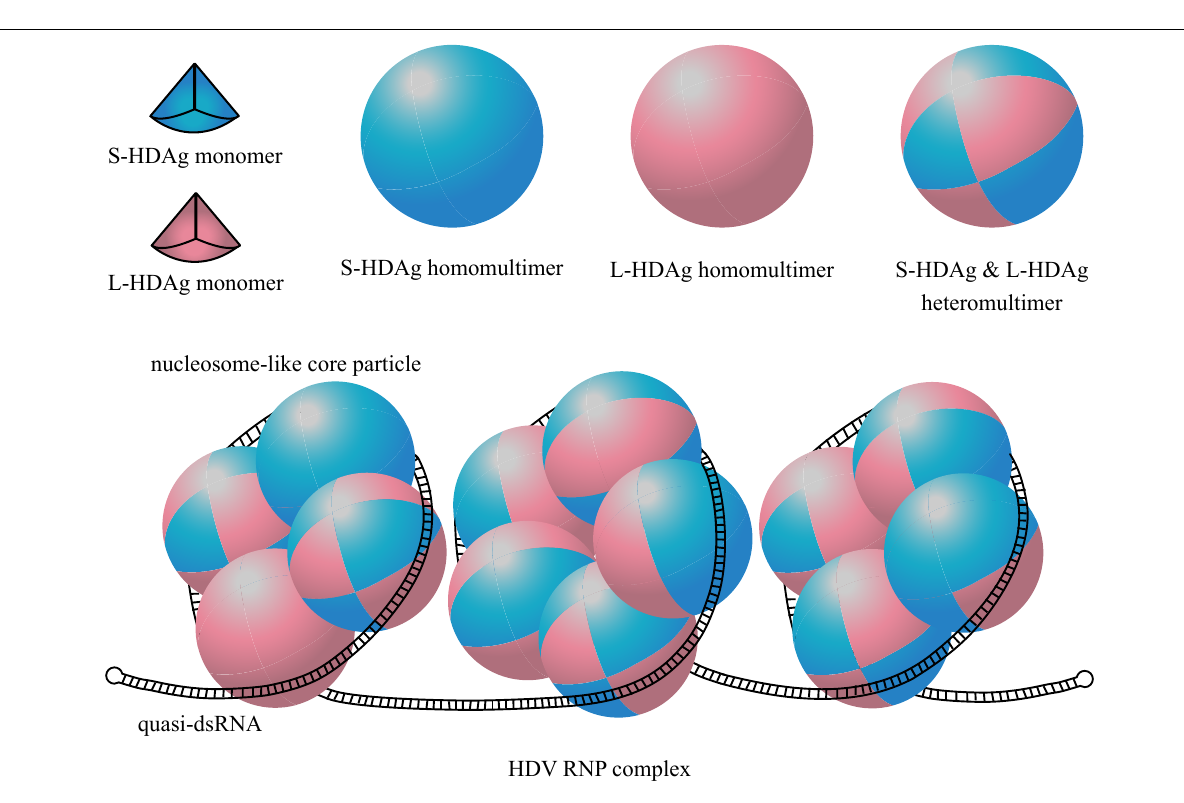
Frontiers in Microbiology |